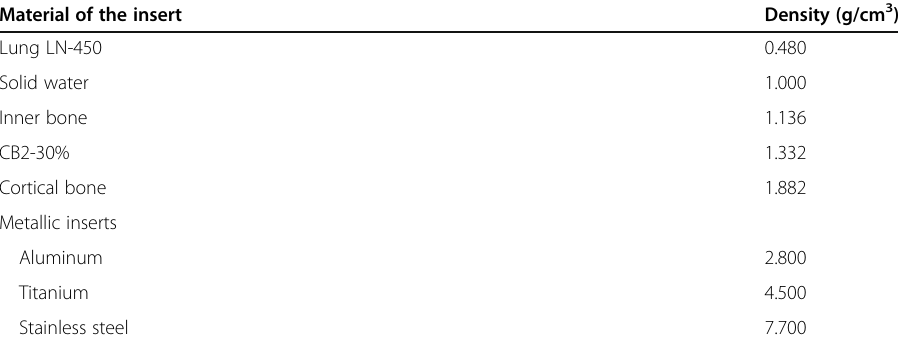
Table 1 Densities of the commercially available (tissue and metallic) placed on the Cheese-